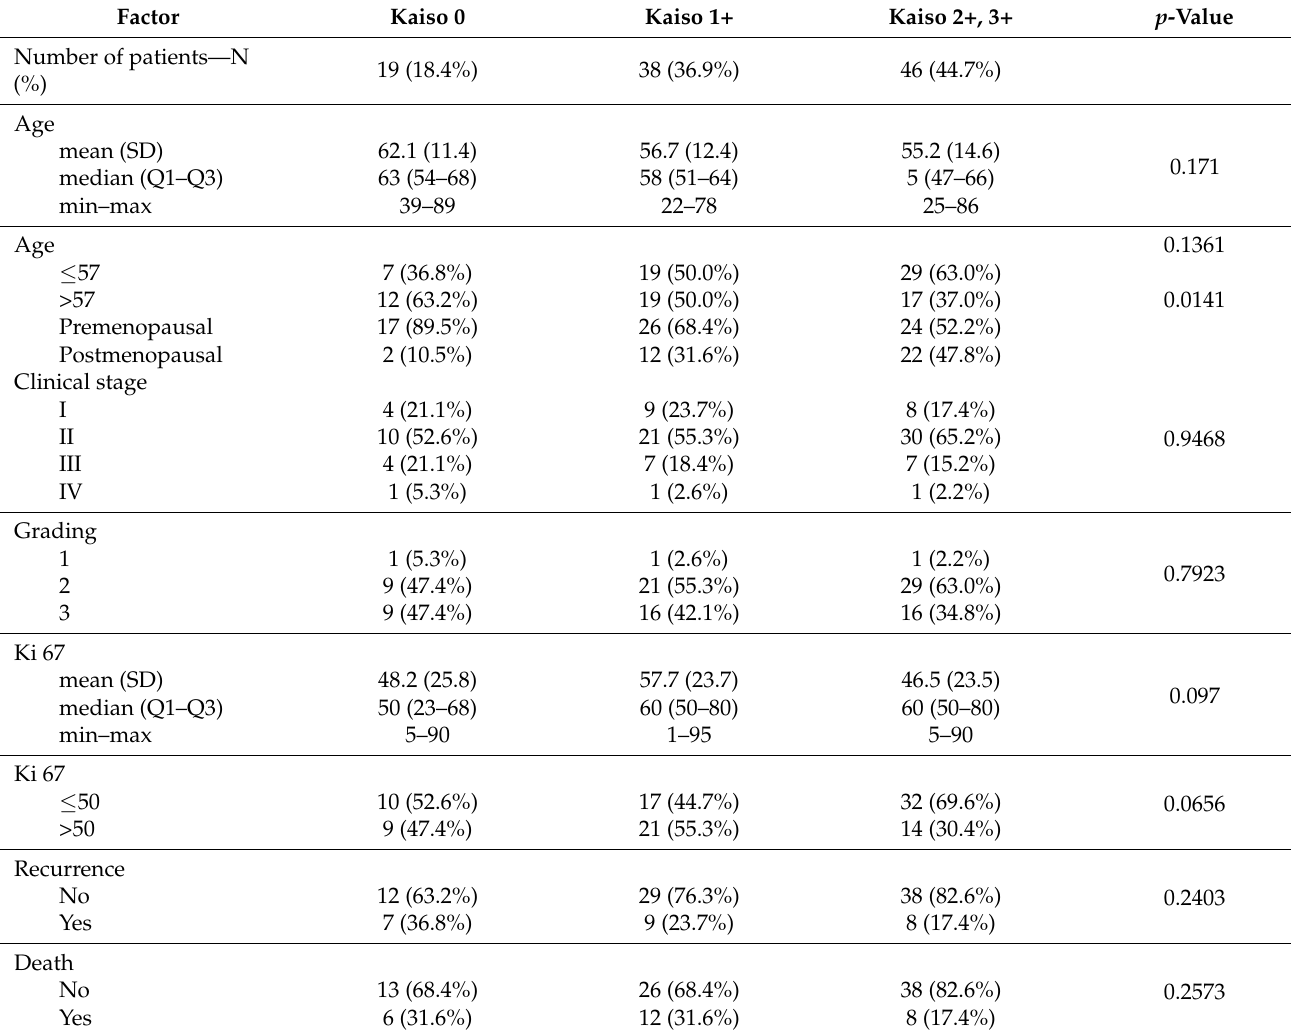
Figure 4. Kaiso immunostaining of TNBC tissues (III grade). IHC images at 40 × magnification show differential staining intensity pattern of Kaiso expression: ( a ) negative (0; <5%), ( b ) low (+1; >5–50%), and ( c ) high (+2; >50%). Table 2. Kaiso expression and clinical